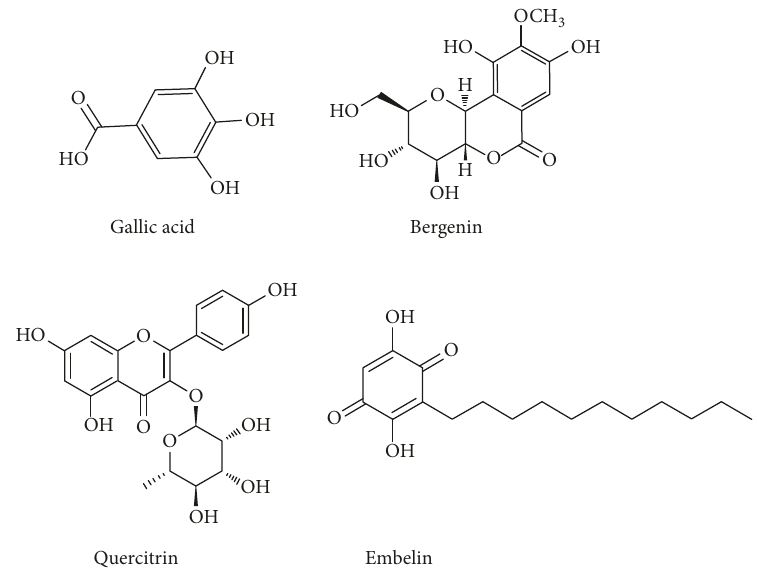
Figure 1: Chemical structures of gallic acid, bergenin, quercitrin, and embelin.